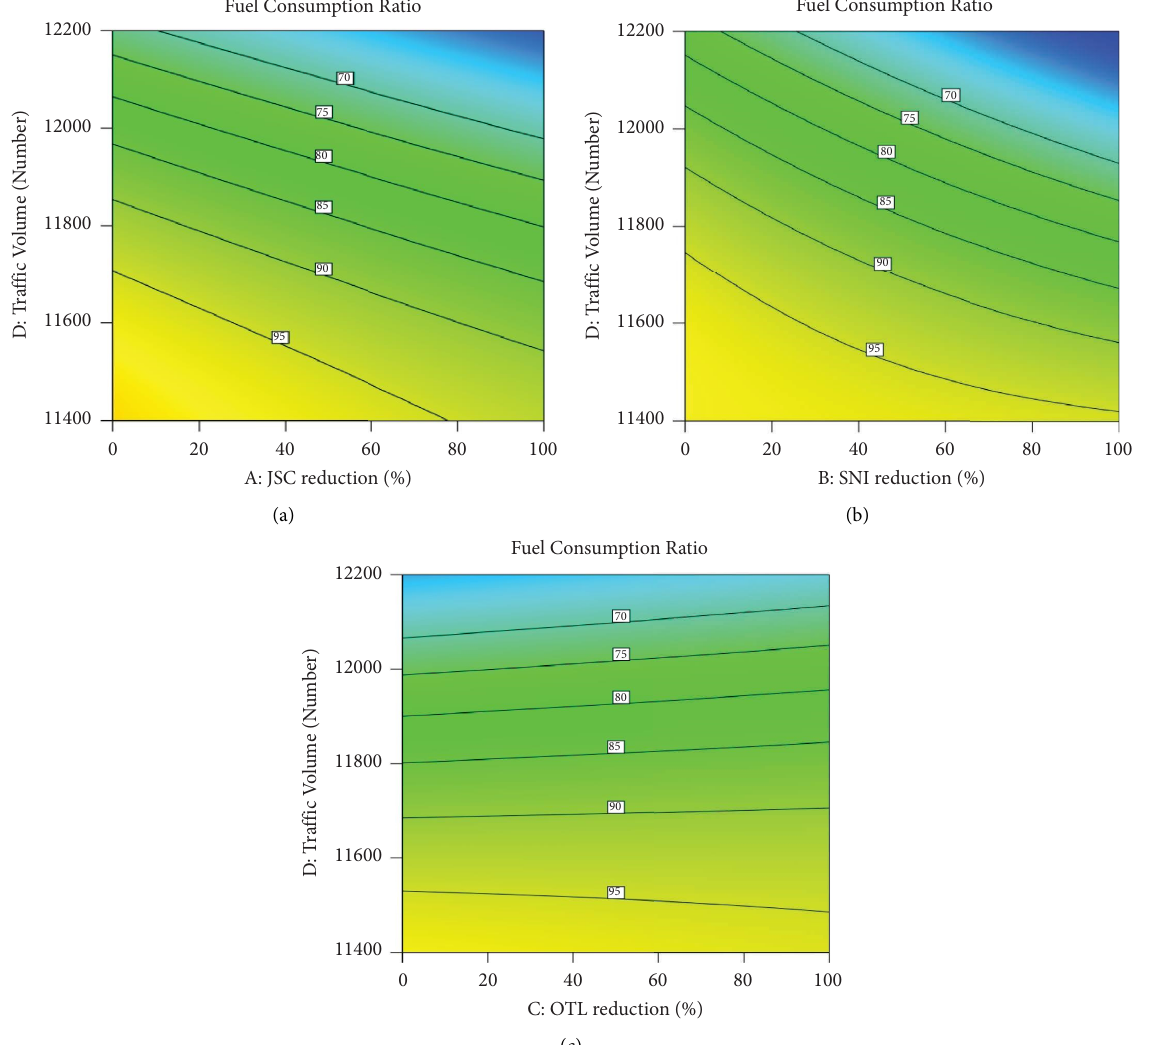
Figure 11: Two-dimensional contour plots of entering trafc volume at the intersection versus (a) JSC, (b) SNI, and (c) OTL for fuel consumption